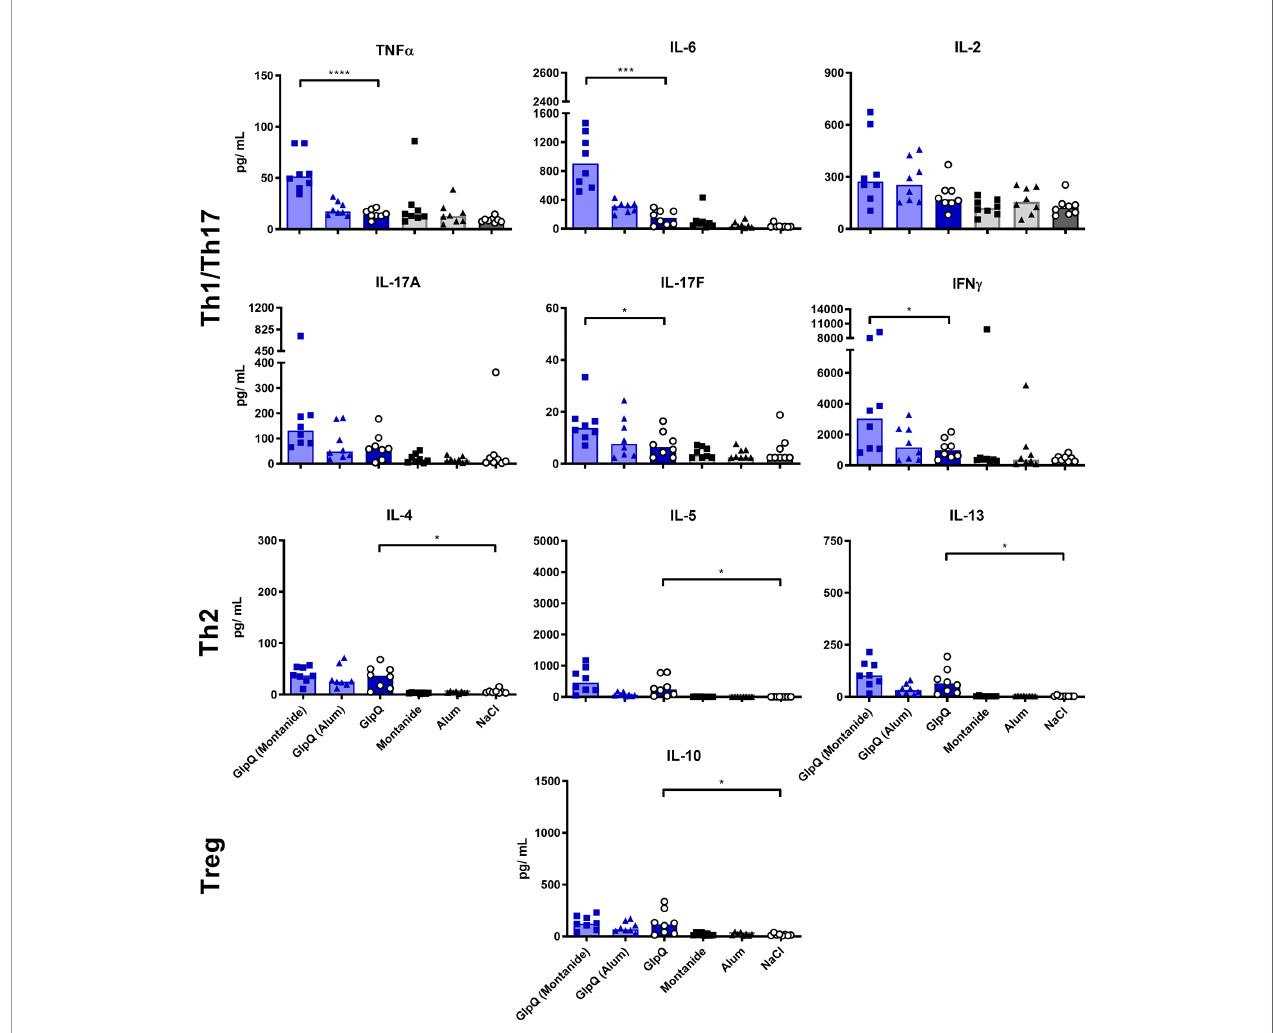
FIGURE 4 | Montanide increased Th1/Th17 cytokine production. Isolated splenocytes were restimulated with GlpQ for 4 days, afterward the supernatant was harvested and the concentration of produced cytokines was measured via the LEGENDplex ™ Mouse Th Cytokine Panel (13-plex). Data are presented as median. n = 8 animals per group. *p < 0.05; ***p < 0.001; ****p < 0.0001. Group comparisons that are de fi ned in the “ Statistical analysis ” section but not shown here are not signi fi